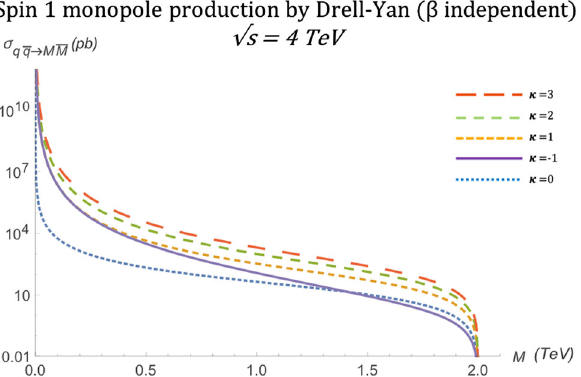
Fig. 18 Angular distributions for monopole-antimonopole pair pro- duction via DY for the case of a monopole with spin 1 / 2 and mass M = 1 . 5 TeV as a function of the scattering angle θ (left) and the